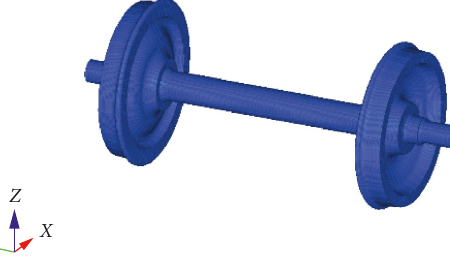
Figure 17: Wheelset finite-element